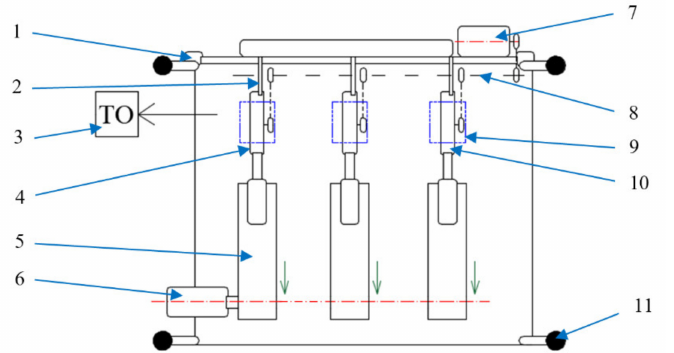
Figure 7. The basic scheme of the stand for determining the sowing precision: (1) frame; (2) depres- sion hose; (3) operating terminal; (4) individual transmission row unit; (5) rubber belt; (6) electric motor driving the individual transmission row unit; (7) electric motor for driving the centralized transmission row units; (8) seed meter drive shaft; (9) laser transducer; (10) centralized transmission row unit; and (11) support legs (adjustable).